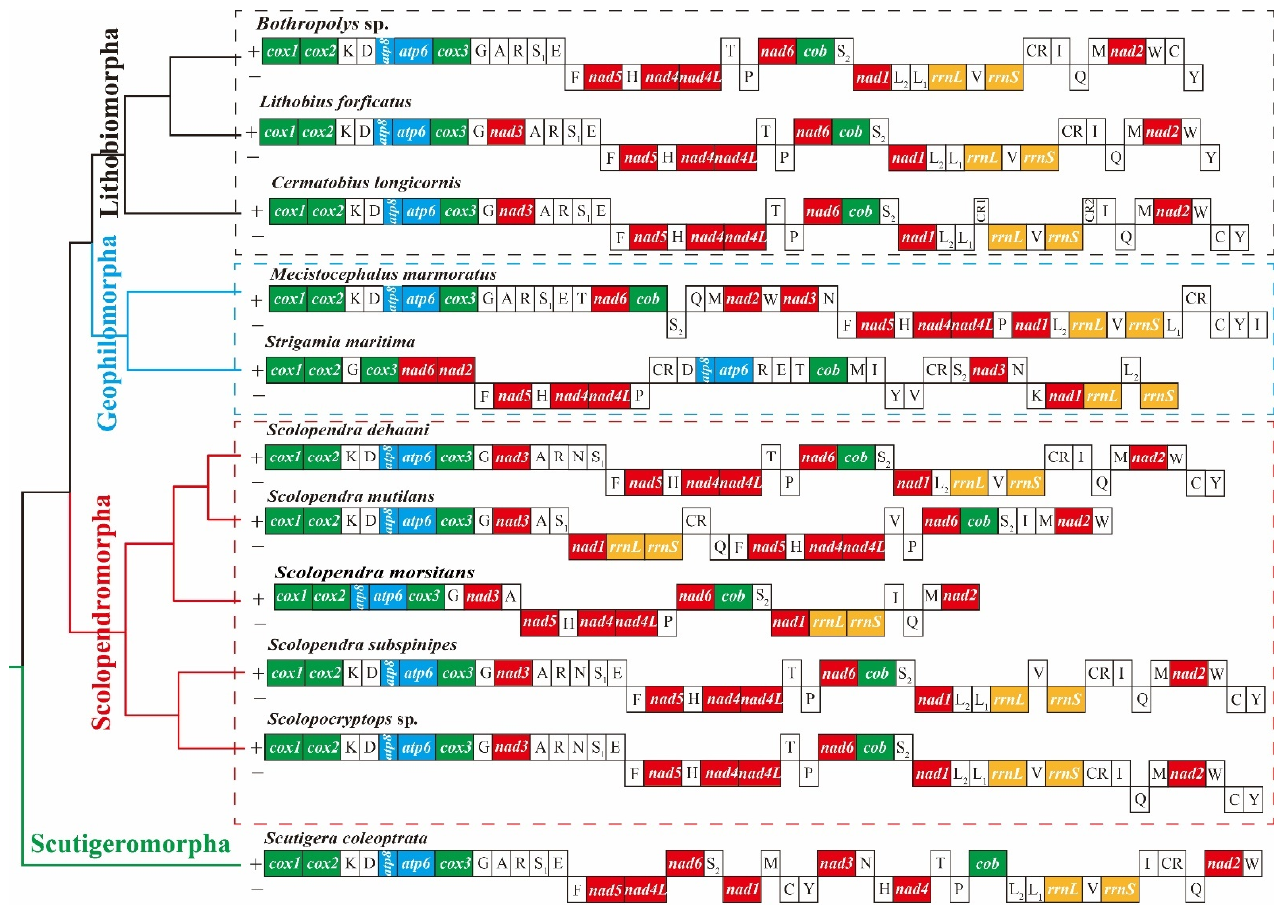
Figure 3. Gene arrangements of the Chilopoda mitochondrial genomes. The mitogenomes have been linearized for ease of comparison and arbitrarily begin with cox1 when possible. Different genes are shown in different colors. Underlined labels indicate that the gene was transcribed from the minority strand.